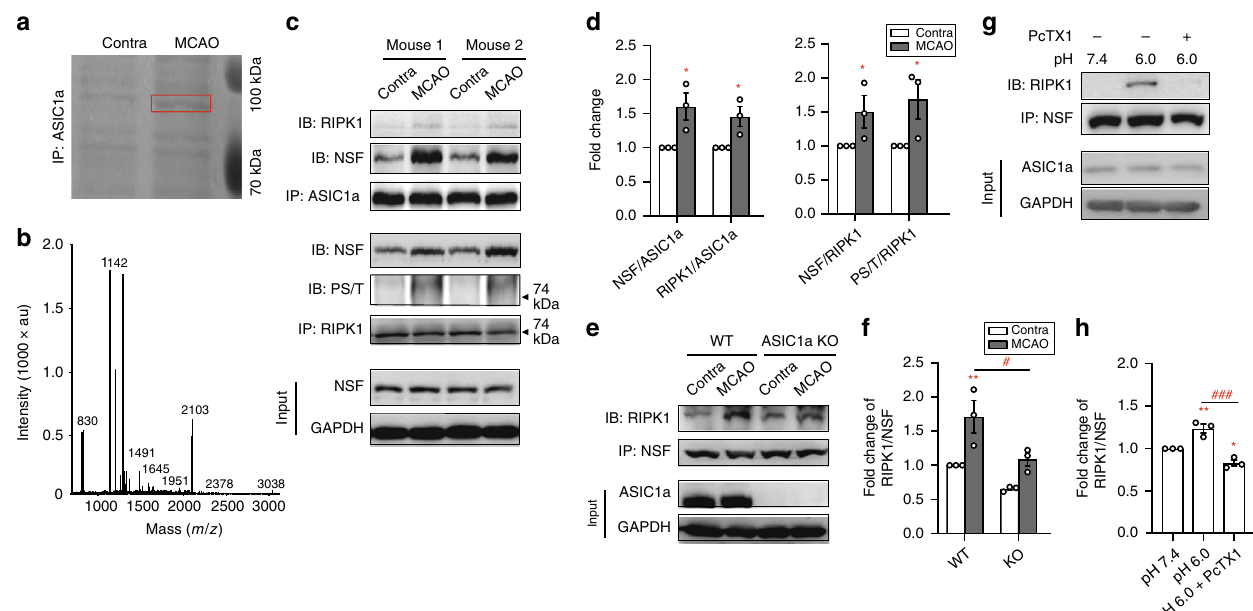
Fig. 3 NSF is recruited to ASIC1a in ischemic brain to form NSF-ASIC1a-RIPK1 complex. a Image of Coomassie blue staining of SDS-PAGE of immunoprecipitants by a polyclonal ASIC1a antibody from contralateral (Contra) and ischemic (MCAO) hemispheres of a mouse subject to MCAO. Red box indicates the band of interest (~85 kD) reproducibly identi fi ed in three independent experiments. b NSF was identi fi ed from the ~85 kD band by MALDI-TOF-MS analysis, in which 18 peptide sequences (out of 39) were found to match NSF (GenBank accession no. 18195) with the protein sequence coverage of 22% (Supplementary Data 1). c Con fi rmation of increased RIPK1-ASIC1a-NSF association in MCAO hemispheres as compared to Contra hemispheres by co-IP. In two examples, both the anti-ASIC1a and anti-RIPK1 antibodies pulled down more NSF from MCAO than Contra groups, along with the markedly increased serine/threonine phosphorylation of RIPK1. Total levels of NSF were not changed after MCAO. d Summary data for ( c ). n = 3, * p < 0.05 vs . Contra by ANOVA. e Asic1a gene deletion prevented the ischemia-induced increase in RIPK1-NSF association. Anti-NSF antibody pulled down more RIPK1 from MCAO than Contra brain samples from WT but not ASIC1a knockout (KO) mice. f Summary data for ( e ). n = 3, ** p < 0.01 vs . Contra, # p < 0.05 vs . WT, by ANOVA. g Acidosis (pH 6.0, 1 h) induced RIPK1-NSF association in cultured neurons, which was prevented by pretreatment with PcTX1 (10 nM added at 0.5 h before and maintained during acidosis). h Summary data for ( g ). n = 3, * p < 0.05, ** p < 0.01, vs . pH 7.4, ### p < 0.05 vs . pH 6.0, by ANOVA. Error bars are SEM for all summary